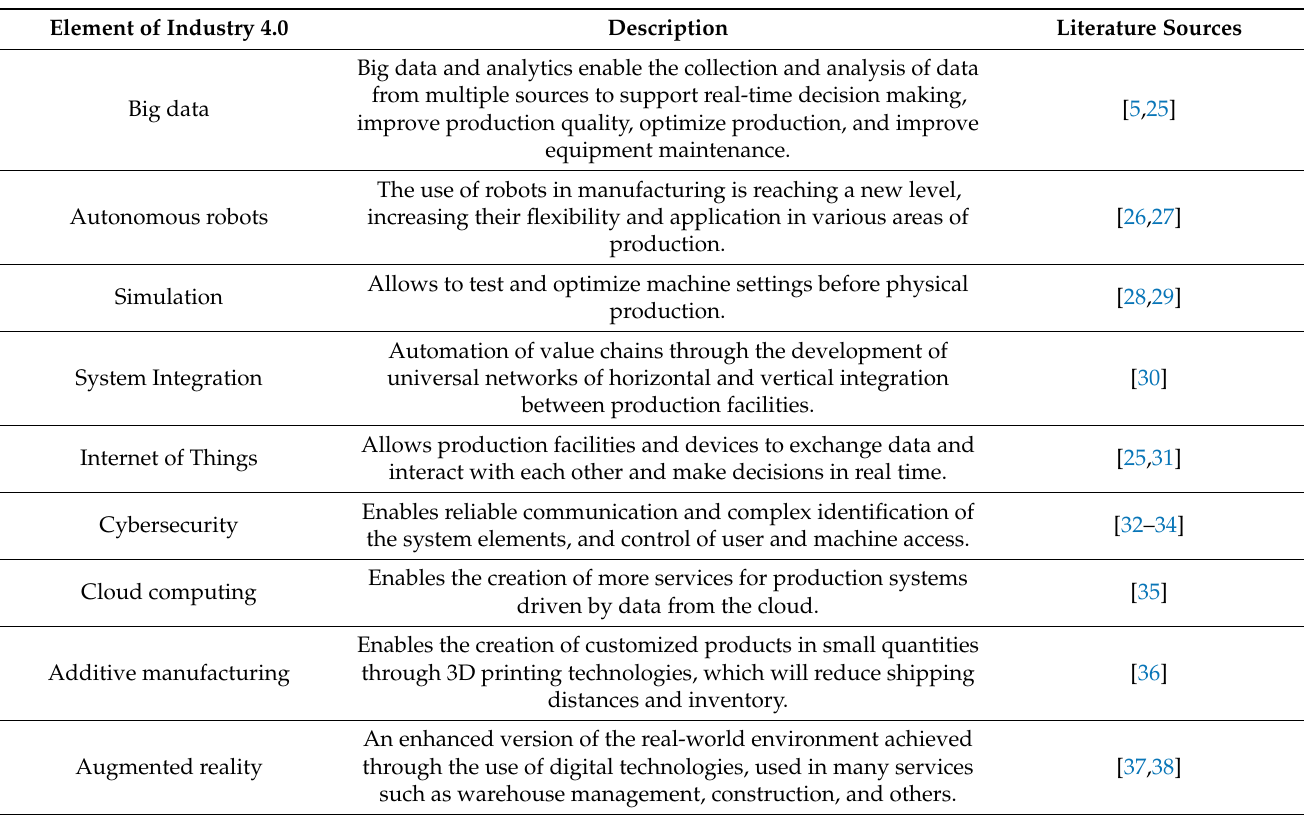
Table 1. Nine pillars of Industry